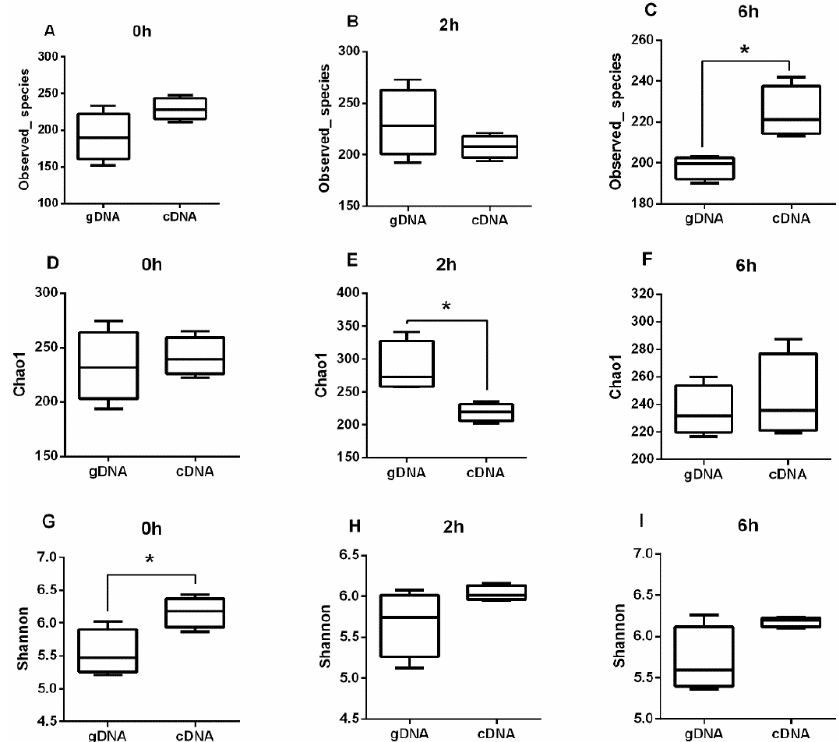
Figure 1. Alpha diversity of rumen ureolytic bacteria across gDNA and cDNA at different time. ( A ) Total observed species, ( B ) Chao1, and ( C ) Shannon index on at 0 h. ( D ) Total observed species, ( E ) Chao1, and ( F ) Shannon index on at 2 h. ( G ) Total observed species ( H ) Chao1 and, ( I ) Shannon index at 6 h. Boxplots indicate the first and third quartiles with the median value indicated as a horizontal line the whickers extend to 1.5 times the inter quartile range. * p < 0.05.